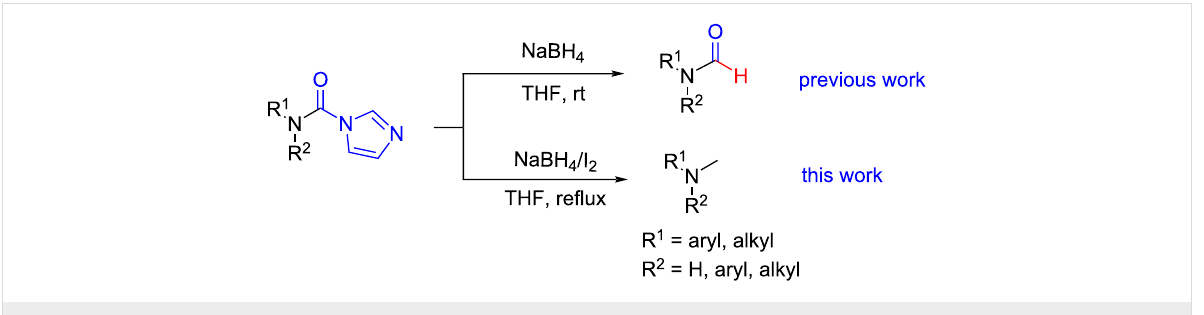
Scheme 1: The synthesis of formamides and monomethylamines.